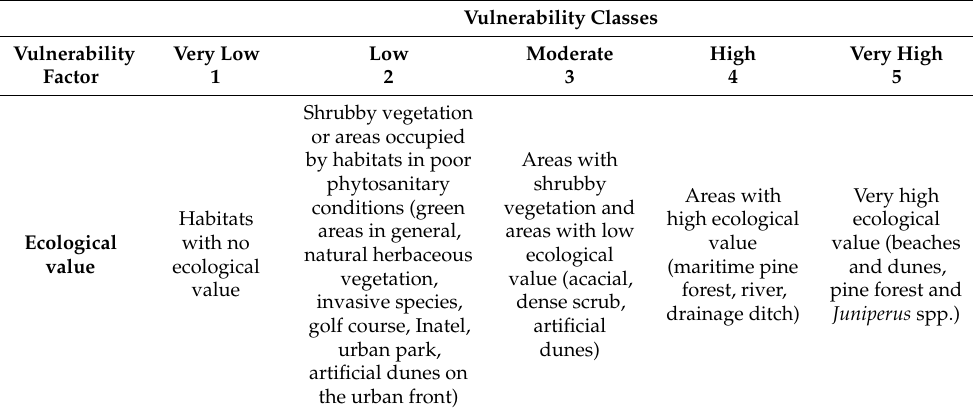
Table 13. Vulnerability classification concerning the ecological value vulnerability subfactor.